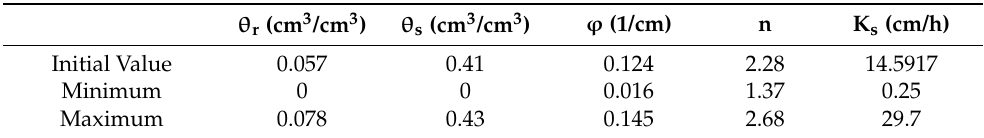
Table 2. The initial, minimum and maximum values of the soil hydraulic parameters in inverse